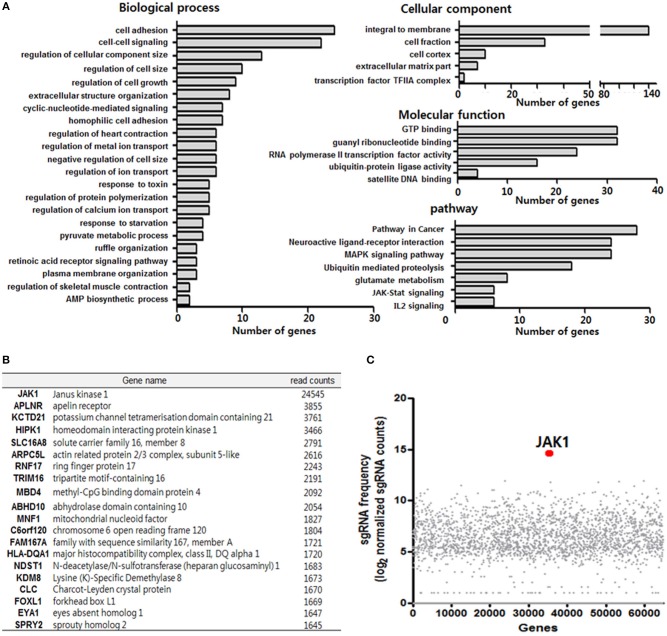
Clustered regularly interspaced short palindromic repeats (CRISPR)/Cas9 library screening of TLR3 ligand (poly IC) resistance genes. (A) Functional annotation clustering analysis of poly IC resistance genes was performed using the DAVID bioinformatics resource. (B) Gene list corresponding to the top 20 hits for resistance following TLR3 activation in MSCs. (C) Scatterplot showing enrichment of sgRNAs after poly IC treatment for 14 days. All data were obtained from two independent experiments.